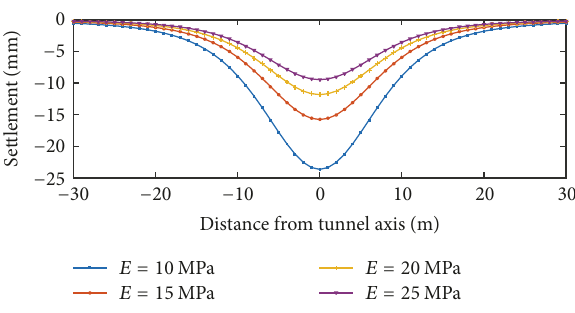
Figure 3: Influence of 𝐸 to surface settlement.